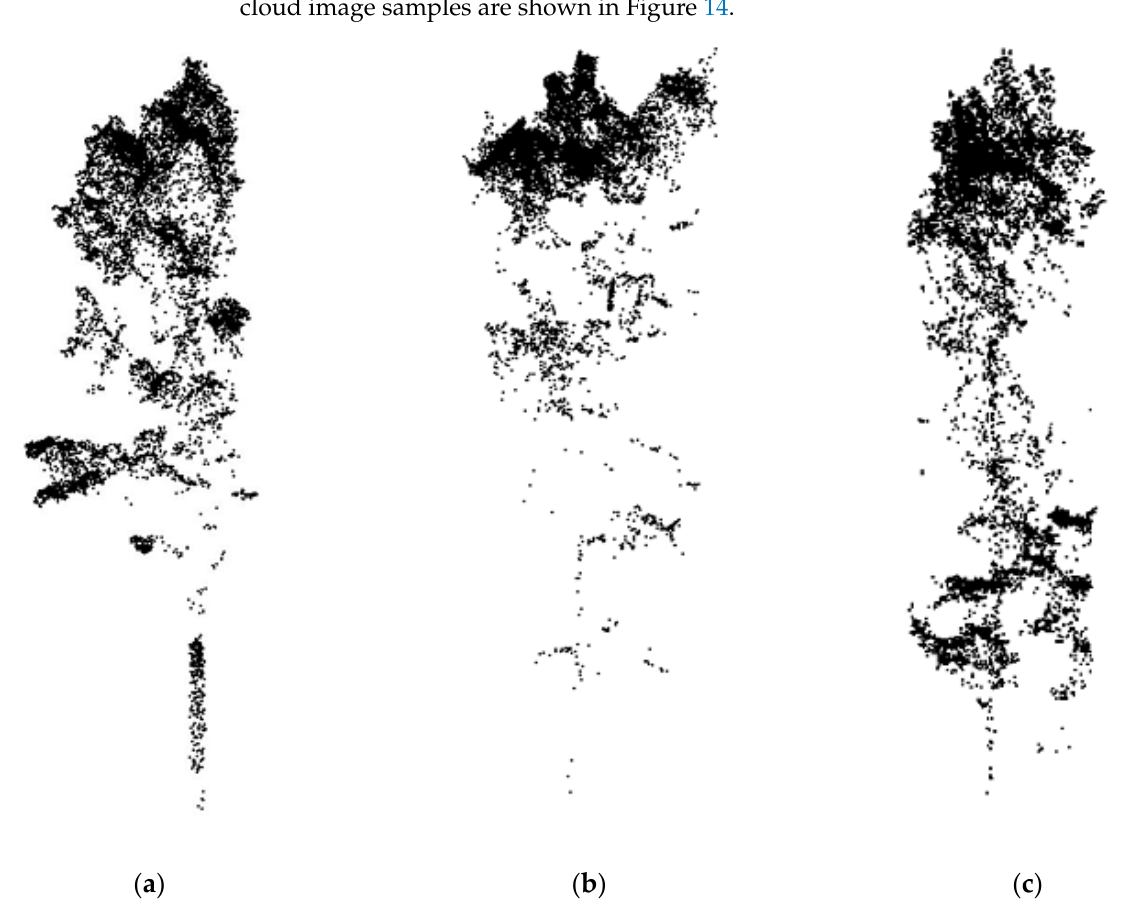
Figure 14. From left to right, the species of tree point cloud is birch ( a ), Quercus mongolica ( b ), and sylvestris ( c ).